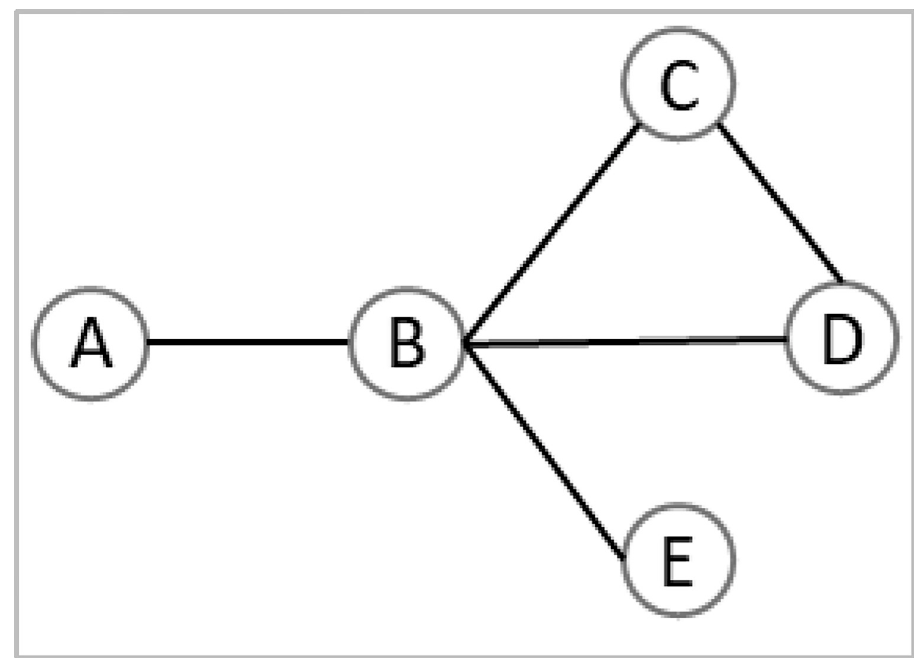
Fig 2. An illustration of a simple network with five nodes and five edges.